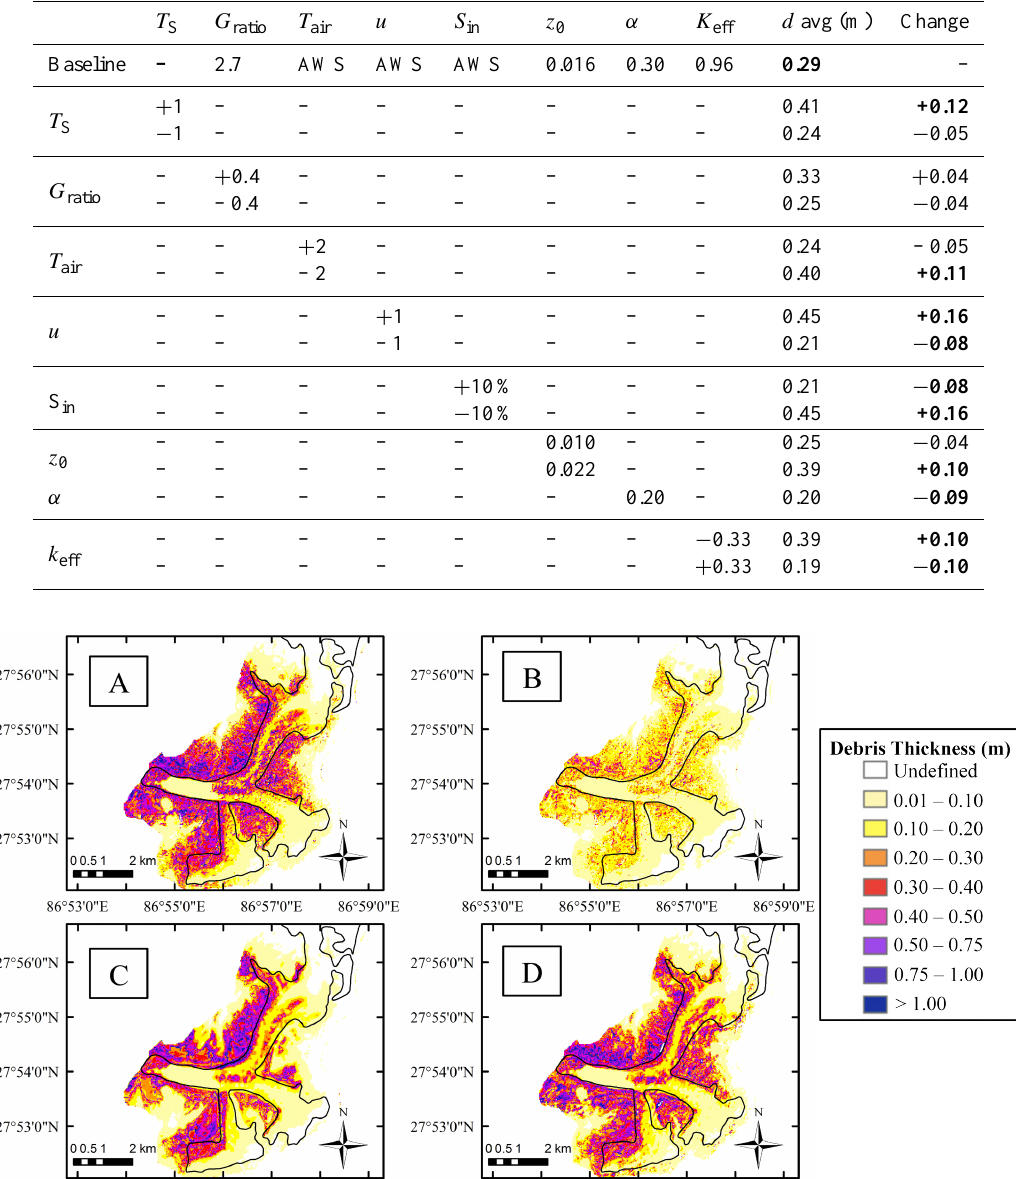
Table 3. Sensitivity analysis for select meteorological and model parameters. Bold numbers showing major changes to average debris thickness and dashes indicating the baseline parameter was used.